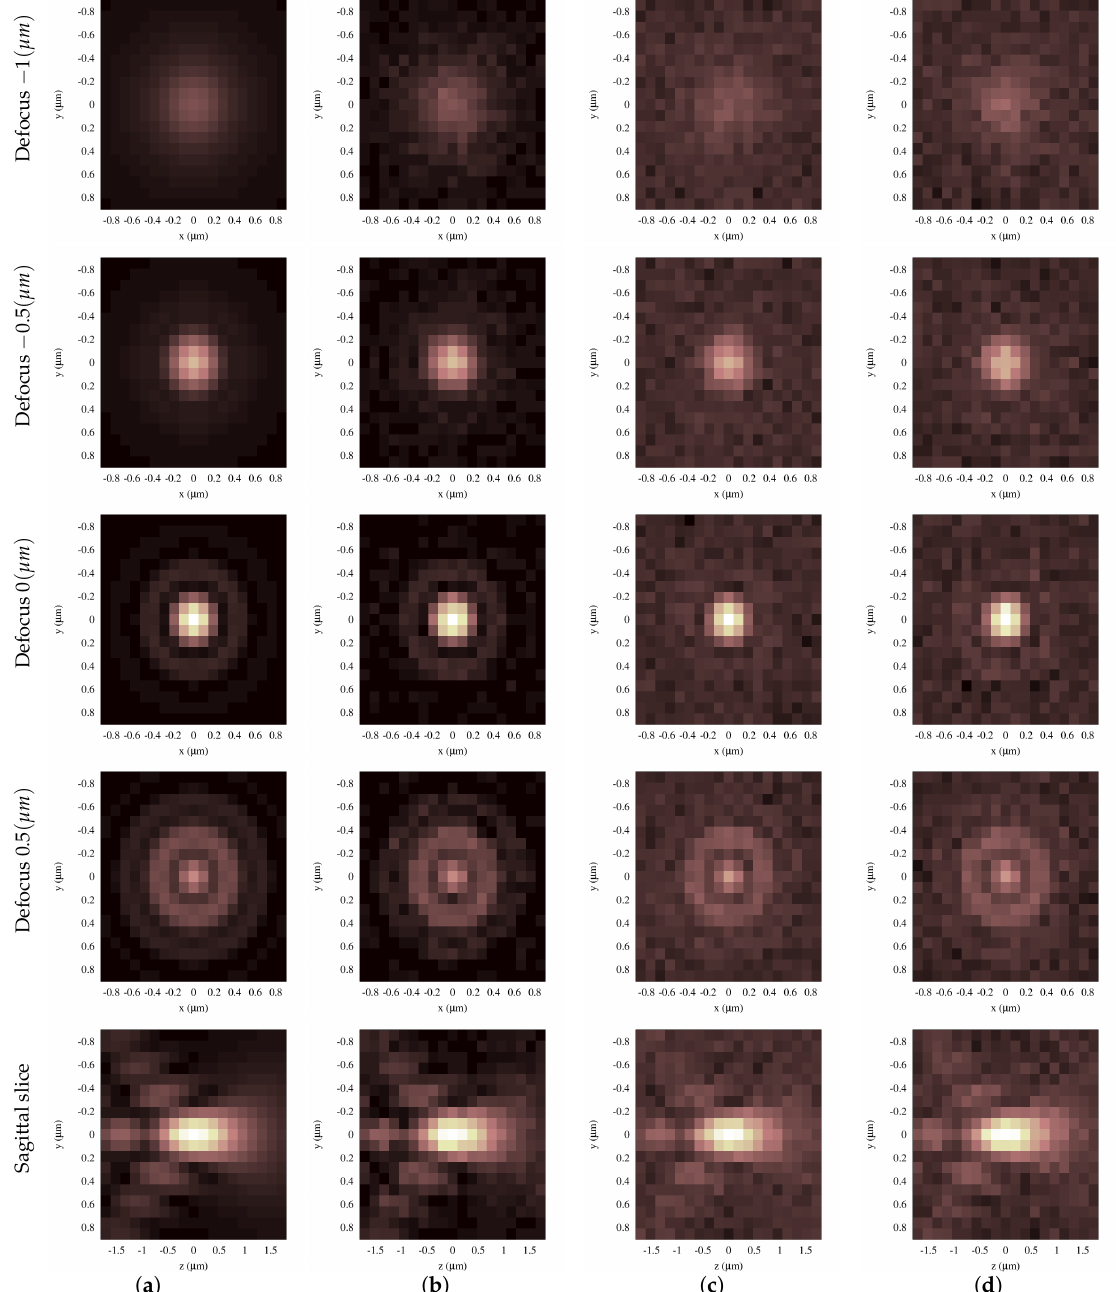
Figure 4. Samples of diffracted-limited images obtained from the Gibson and Lanni model [13] are shown in the column marked ( a ). The same images degraded by different noise conditions are shown in the columns marked ( b – d ). The last row depicts the samples of sagittal slices. ( a ) Without noise; ( b ) NCI; ( c ) NCII; ( d )